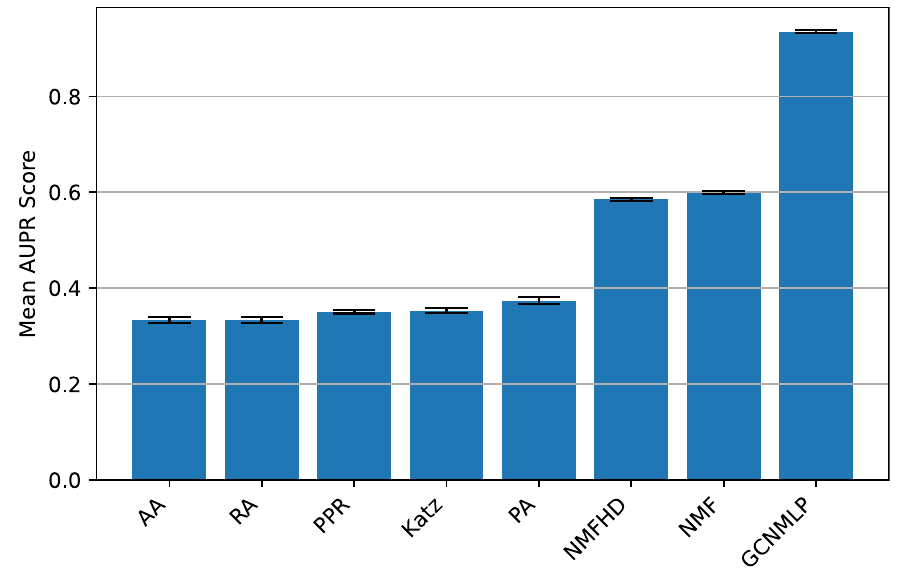
Fig 3. Comparing the performance of various algorithms on AUPR